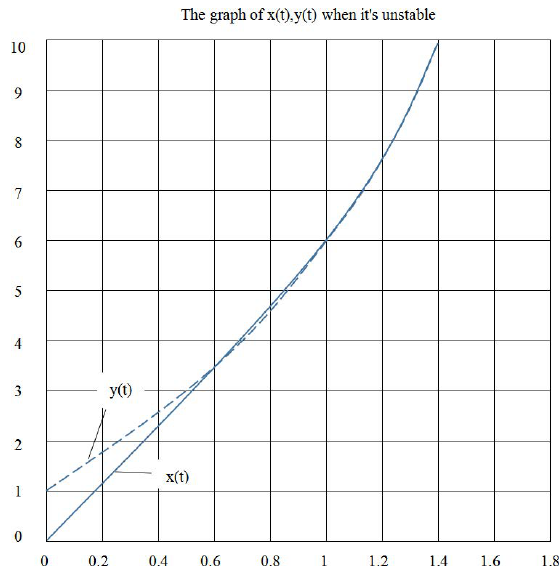
Fig. 3 Alpha beta & lt; the trend of x ( t ) and y ( t ) at k 1